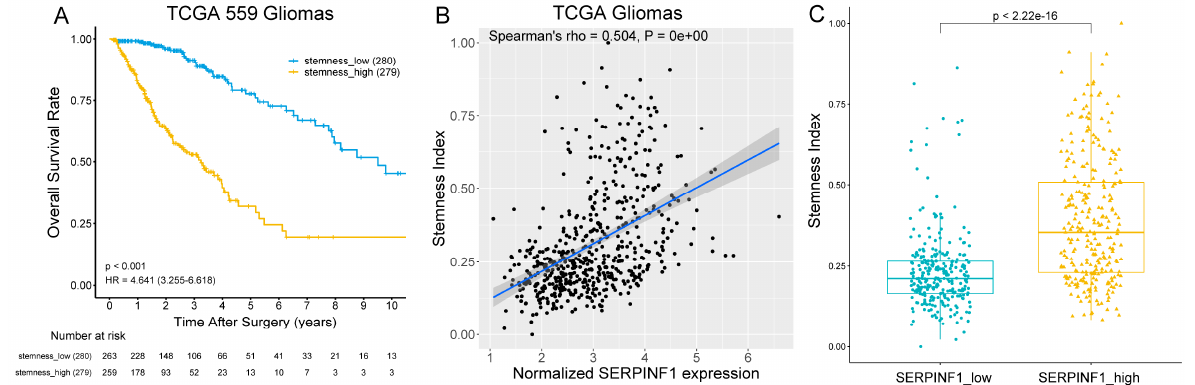
Figure 4. The association between SERPINF1 expression and glioma stemness. ( A ) Kaplan–Meier survival curves based on glioma stemness in TCGA. ( B ) Spearman’s correlation analysis between SERPINF1 expression and glioma stemness. ( C ) The difference in glioma stemness between high- and low-SERPINF1 groups.